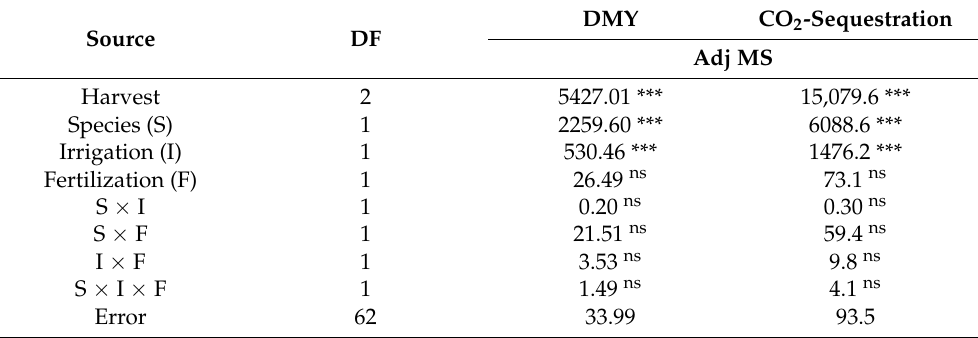
Table 1. Repeated measures ANOVA for main effects and interactions on aboveground dry matter yield (DMY) and aboveground CO 2 -sequestration of Arundo donax and Miscanthus × giganteus . Degrees of freedom (DF) adjusted mean square (Adj MS) and significance: p ≤ 0.001 (***), not